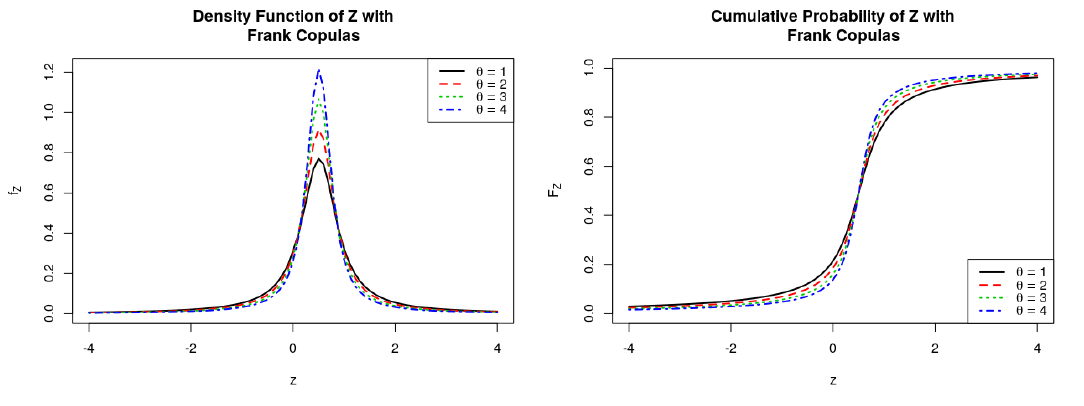
, where ( X 1 , X 2 ) follows Frank Copulas. X 2